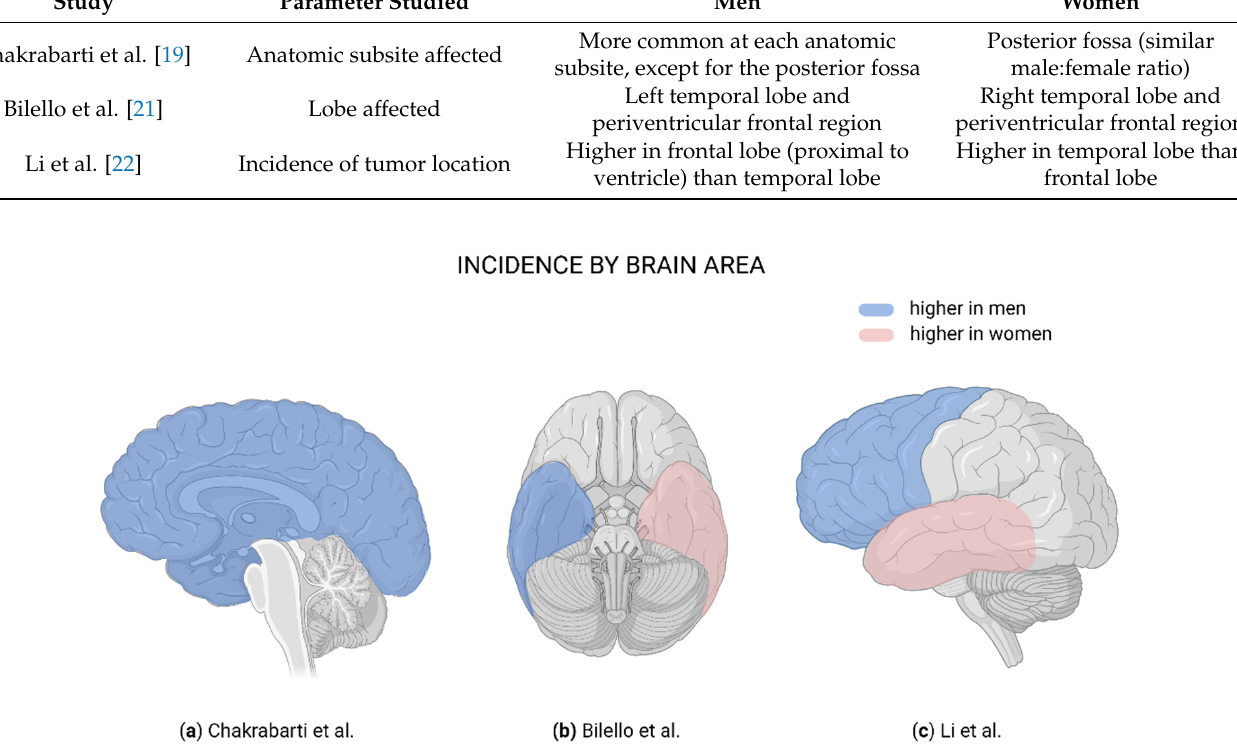
Figure 1. Brain regions affected in glioblastoma. ( a ) Blue indicates a higher male:female ratio in incidence [19]. ( b ) Blue indicates more frequently affected in men; pink, more frequently affected in women [21]. ( c ) Blue indicates more frequently affected in men; pink, more frequently affected in women [22]. Created with